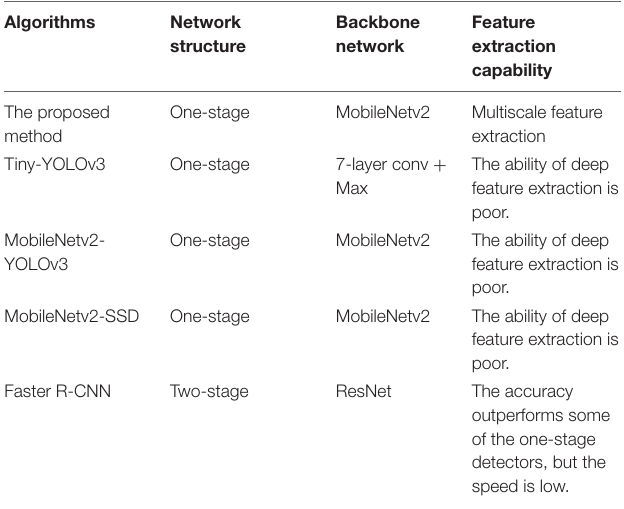
TABLE 2 | Comparison of the characteristics of different